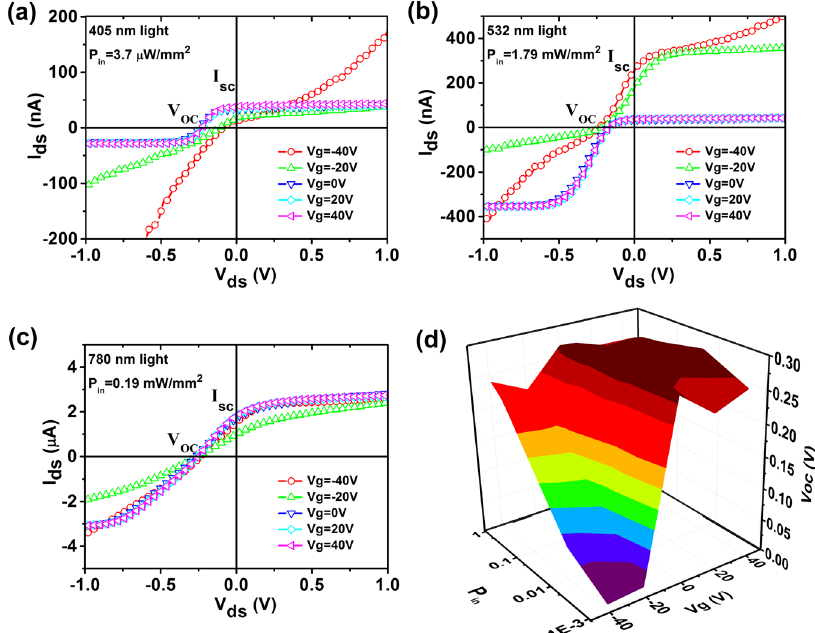
Fig. 5 Broadband photoresponse of the self-driven photodetector. I – V curves of the self-driven graphene – WSe 2 – Au photodetector under varying light wavelengths of a 405 nm, b 532 nm, and c 780 nm. d Dependence of the V oc on the gate voltage bias and light power density under 780 nm light